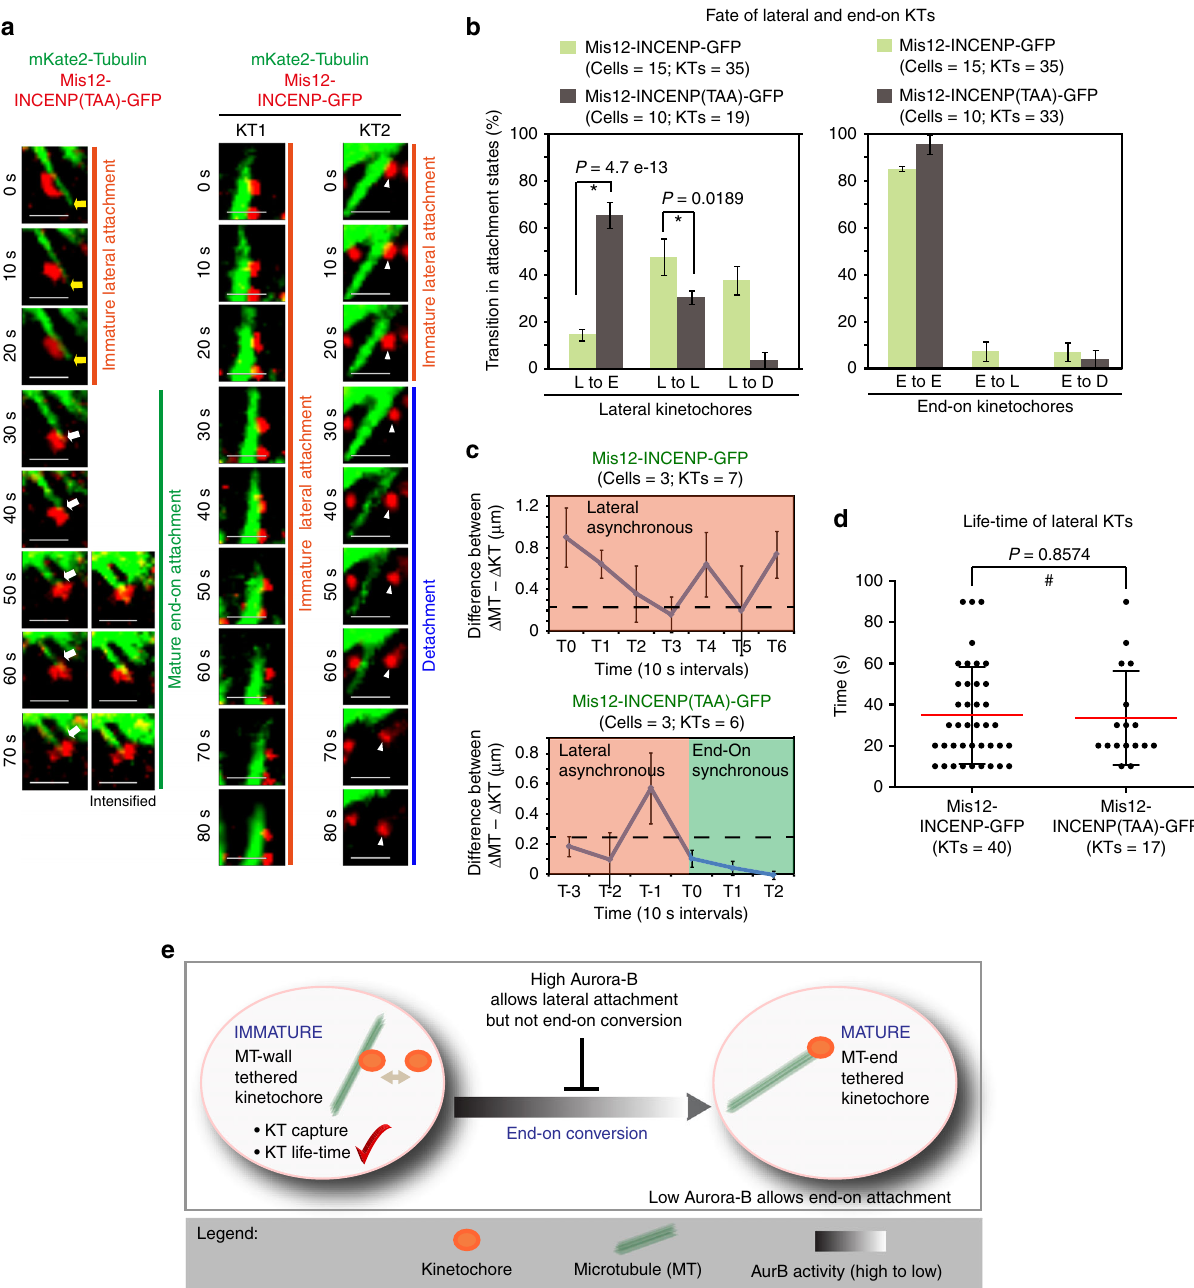
Fig. 2 Constitutive Aurora-B activity at the outer-kinetochore allows lateral attachments but disrupts end-on conversion. a Single-plane time-lapse images of Z-stacks show the fate of a lateral KT ( red ) attached to MT ( green ). Time-lapse images of HeLa cells expressing mKate2-Tubulin and either Mis12- INCENP-GFP or Mis12-INCENP (TAA)-GFP mutant were acquired in the presence of Monastrol. Yellow arrows mark shrinking lateral K- fi bre and white arrows show the synchronous movement of the KT with MT-end. White arrowheads mark the KT tracked. For three fi nal time-points ( left panels ) ‘ intensi fi ed ’ images are included to highlight the K- fi bre. Scale bar: 2 μ m. b Graphs show the percentage of lateral ( left ) or end-on ( right ) kinetochores that transitioned into other attachment states (D-detached, L-lateral and E-end-on) in time-lapse movies as in a . c Graph shows the difference between Δ MT (change in MT-end position) and Δ KT (change in KT position) through time, used to de fi ne synchronous or asynchronous movements. Values less than 0.25 μ m (marked by dashed line ), sustained for at least 30 s, are indicated as synchronous ( green ) movement between the KT and MT-end. All other values are indicated as asynchronous movements of the KT and MT-end. d Graph shows the time spent by lateral kinetochores on MT-walls, before changing into another attachment state, in cells expressing either Mis12-INCENP-GFP or Mis12-INCENP (TAA)-GFP. Red and black bars mark mean-time and SD values, respectively, across kinetochores in three experiments. Error bars in b and c are SEM values across experiments b or across kinetochores c . ‘ * ’ and ‘ # ’ indicate statistically signi fi cant and insigni fi cant differences, respectively, on the basis of P -values obtained across three experimental repeats using a Proportion test b or unpaired Student ’ s t -test d . e Cartoon shows how Aurora-B at the outer-kinetochore disrupts the end-on conversion process by detaching lateral kinetochores prior to end-on conversion. Aurora-B at the outer-kinetochore does not interfere with the capture or maintenance of kinetochores on microtubule walls. Reducing Aurora-B activity allows the formation of mature end-on